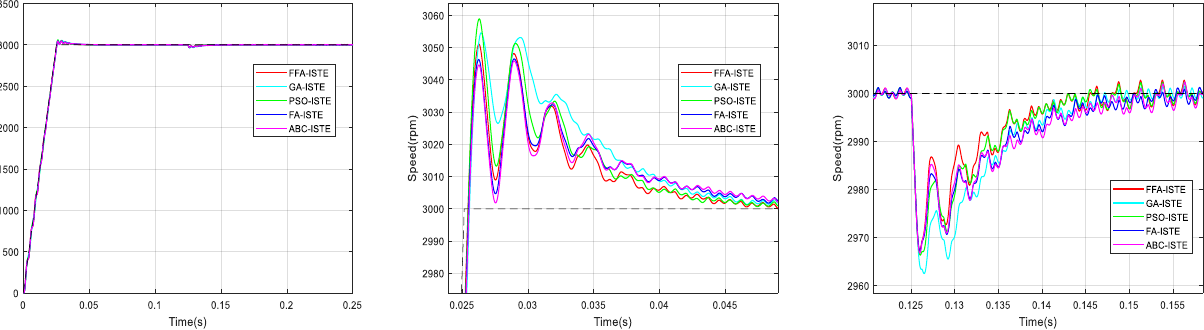
Figure 15. Comparison of speed responses with different algorithms using ISTE criterion: ( a ) original; ( b ) and ( c ) zoomed